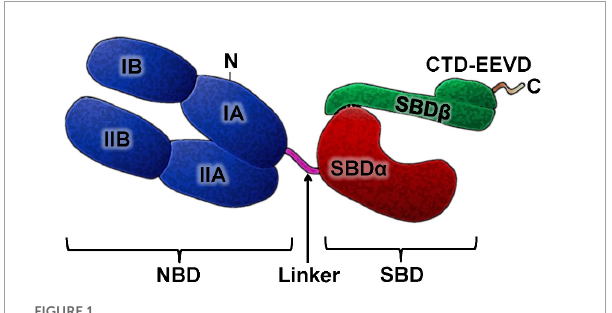
FIGURE1 HSP70 structure. The HSP70 family members has a highly conserved N-terminal nucleotide-binding domain (NBD) and C-terminal substrate-binding domain SBD and in its structure. NBD and SBD are connected by a linker. The SBD domain is subdivided into a sandwich subdomain (SBD α ) and α -helical lid subdomain (SBD β ) followed by unstructured C-terminal domain (CTD), which in many cytosolic Hsp70s is often ends with a charged EEVD